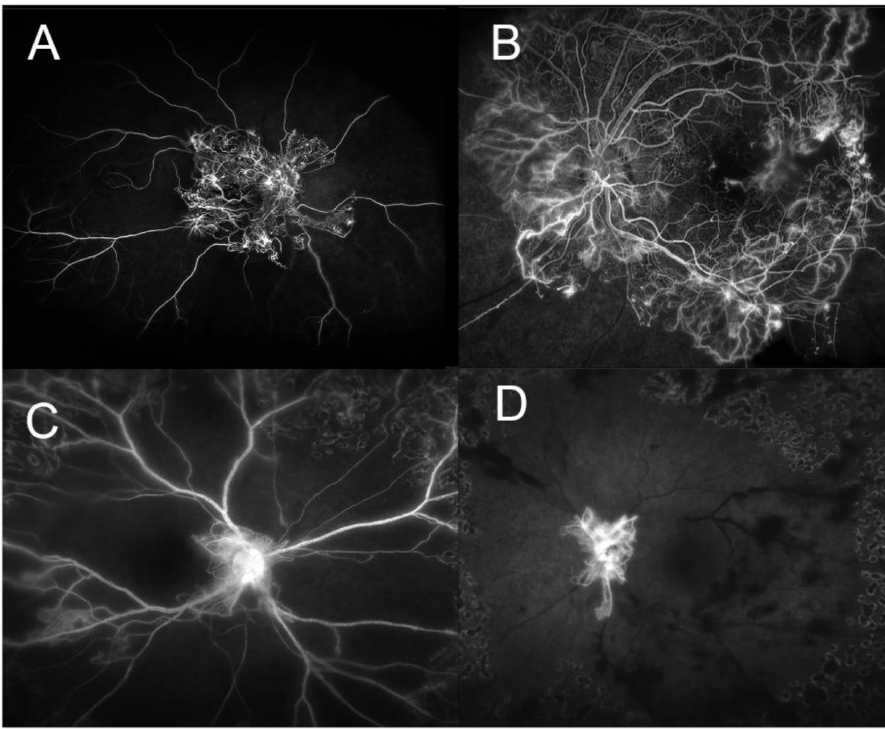
Figure 1. Angiographic evidence of the loss of normal retinal vasculature contributing to the breakdown of the blood–retinal barrier in uncontrolled diabetes mellitus. ( A ) Right eye of a 29-year- old African American female with peak arterio-venous phase showing neovascularization and no capillary perfusion beyond the posterior pole. ( B ) Same patient’s left eye showing an enlarged foveal avascular zone, and heavy neovascularization at the border of retinal perfusion and non-perfusion. ( C , D ) are from a 28-year-old African American female showing global retinal ischemia with little perfusion beyond the peripapillary vasculature. (Images courtesy of Siva S.R. Iyer,